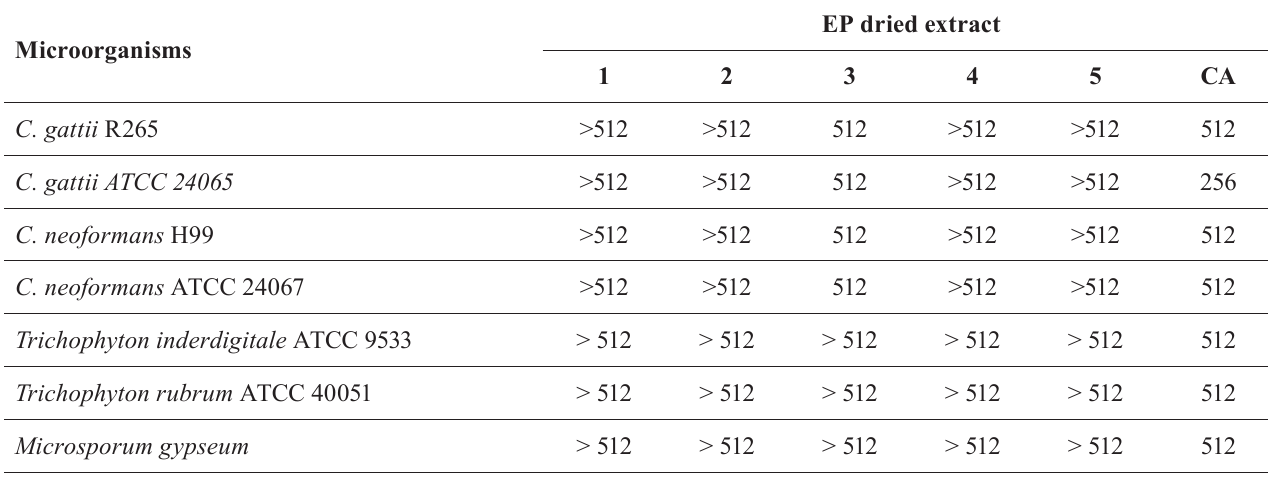
TABLE I - D etermination of MIC for EP dried extracts regarding different fungal strains